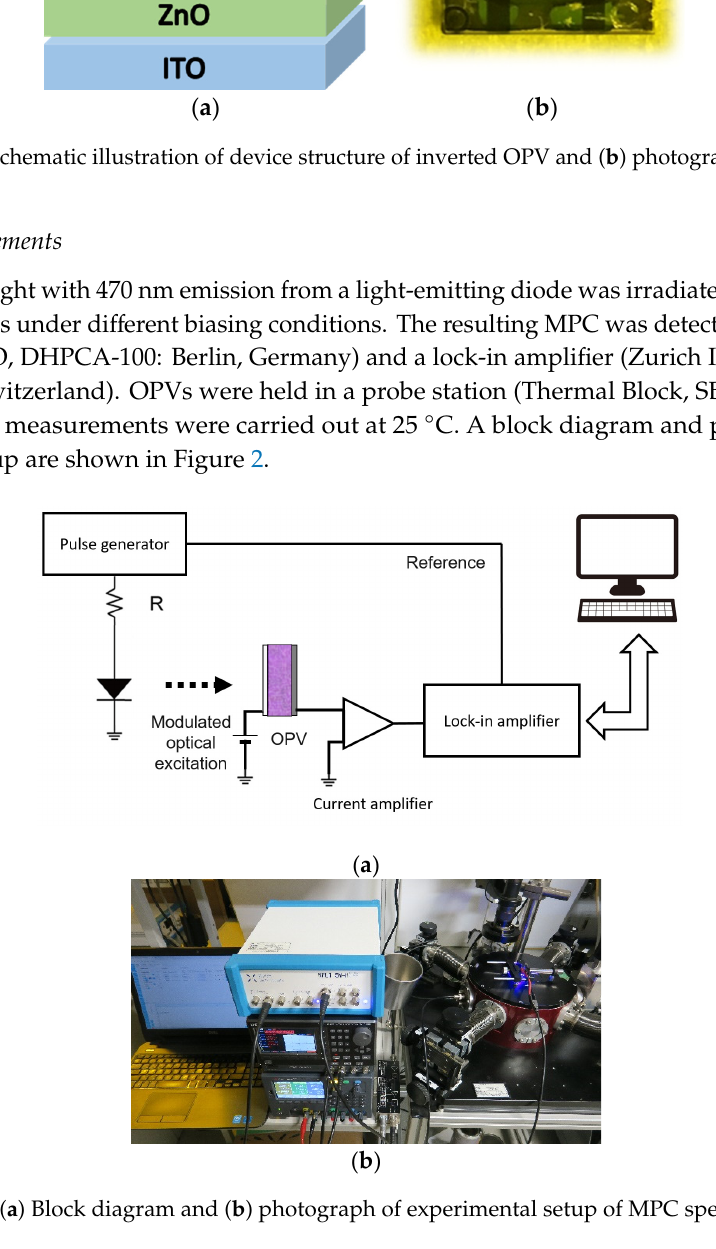
Figure 2. ( a ) Block diagram and ( b ) photograph of experimental setup of MPC spectroscopy.